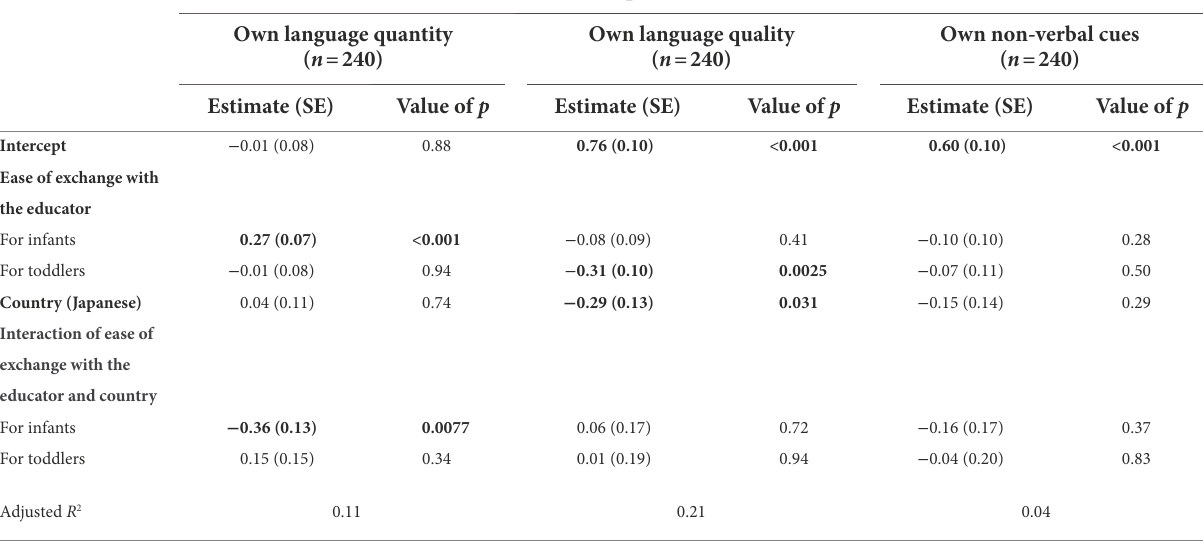
TABLE 10 The linear regression models predicting educators’ own communicative behavior toward children.